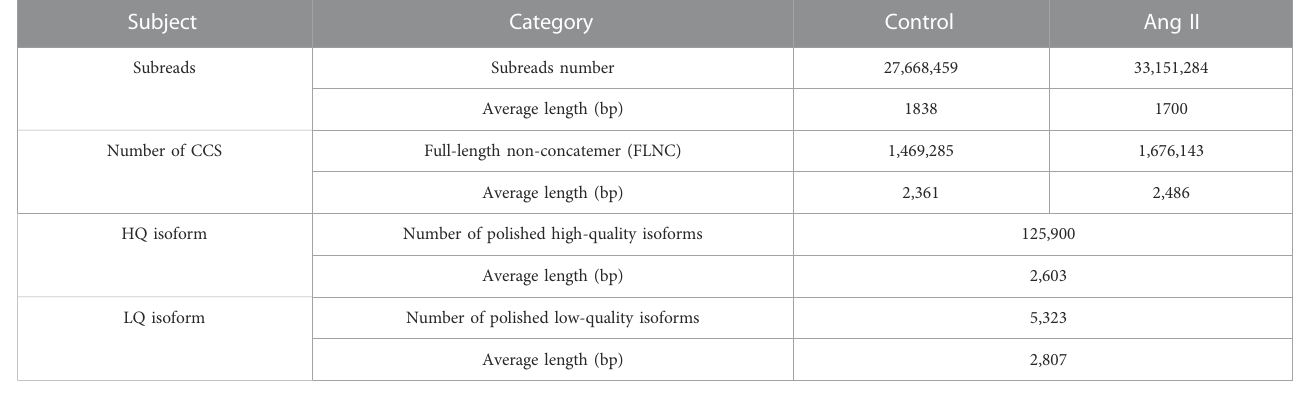
TABLE 1 Summary of PacBio raw data analysis of Control and Ang II in RAECs.